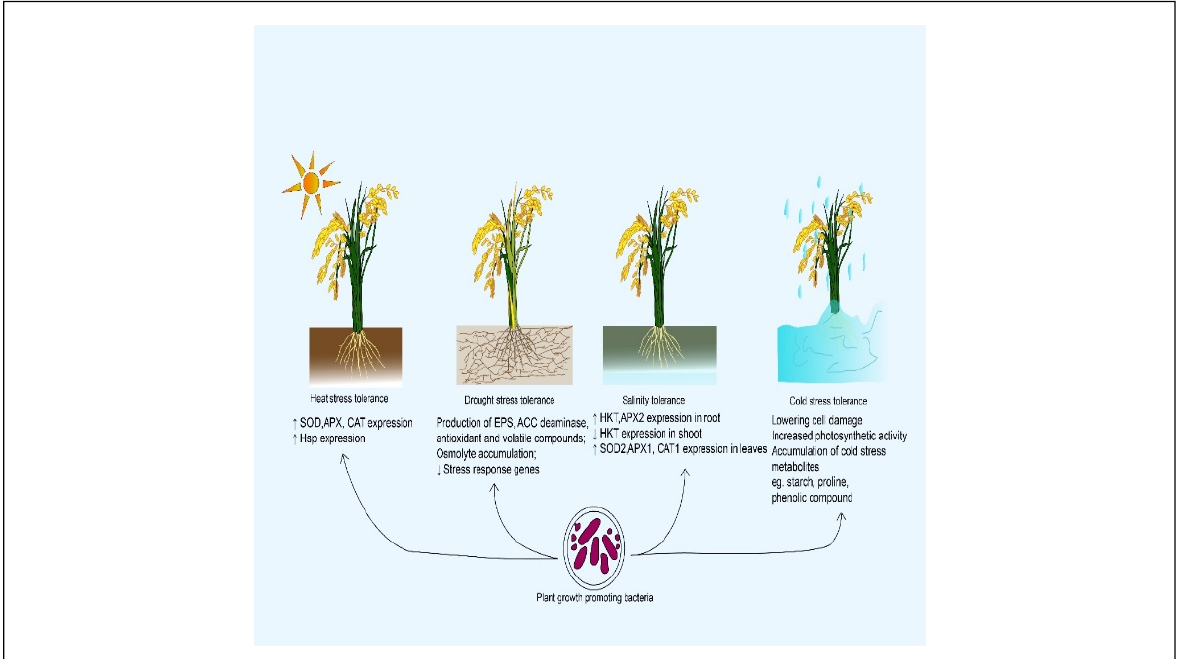
Figure 3: Abiotic stress tolerance: Plant growth promoting bacteria exploit multiple strategies to make rice plant tolerant to abiotic stresses such as drought, cold, salinity and heat stress. SOD: Superoxide dismutase, APX: Ascorbate peroxidase, CAT: Catalase, EPS: Extracellular polymeric substances, ACC: 1-Aminocyclopropane- 1-carboxylate, HKT1: High affinity K + transporter